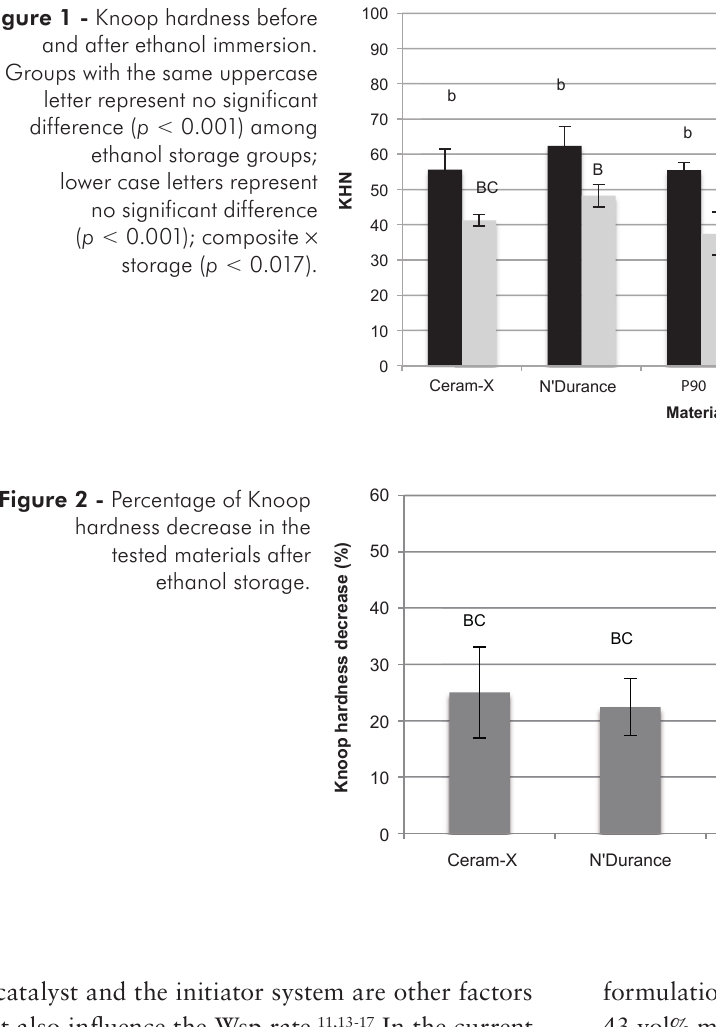
Figure 1 - Knoop hardness before and after ethanol immersion. Groups with the same uppercase letter represent no significant difference ( p < 0.001)